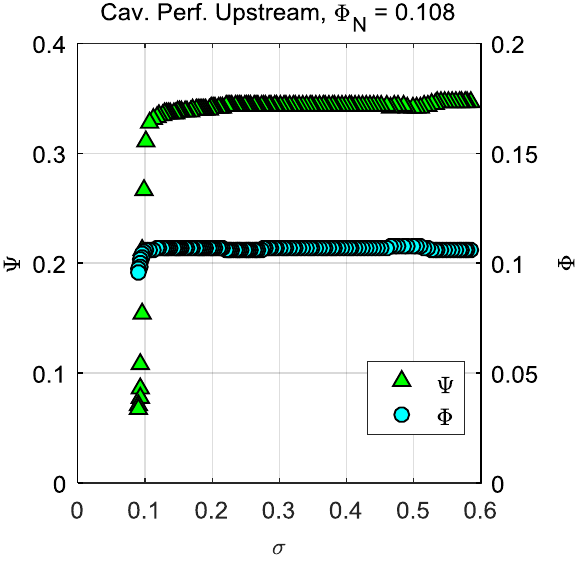
Figure 8. Cavitating performance (head coefficient Ψ versus flow coefficient Φ ) and flow coefficient evolution, nominal Φ 𝑁 = 0.108 (90% Φ 𝐷 ).